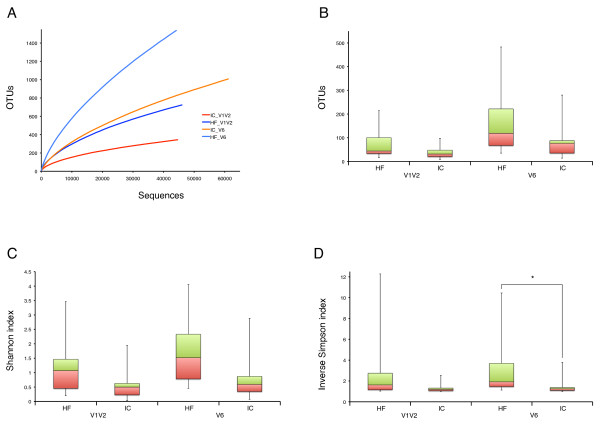
Comparison of richness and diversity estimations of urine from interstitial cystitis (IC) patients and healthy females (HF). A: Rarefaction curves depicting number of OTUs (at 3% genetic difference) as function of the total number of sequences for the combined sequence pool datasets for IC urine V1V2 and V6 (red and orange) and HF urine V1V2 and V6 (dark and light blue). The curves show a decreased estimate of species richness in the IC urine microbiome compared to the HF urine microbiome. B, C, and D: Box plots showing richness and diversity of 16S rDNA sequences. Boxes contain 50% of the data and have lines at the lower quartile (red), median and upper quartile (green) values. Ends of the whiskers mark the lowest and highest value. The plots show the results of a combined assessment of the eight urine samples in each HF and IC microbiome and with normalized numbers of sequences for OTU and Shannon index values (B and C). B: Observed OTU counts (at 3% genetic difference) of all urine samples taken from HF and IC, for both V1V2 and V6 datasets. C and D: Shannon index and inverse Simpson index at 3% sequence dissimilarity calculated to estimate diversity for both V1V2 and V6 datasets. Asterisks (*) indicate significant differences (Wilcox rank sum test: * p < 0.05). Note that a single sample (P2) in the IC community is the only outlier with the highest values for both richness and diversity (for both V1V2 and V6 analysis).